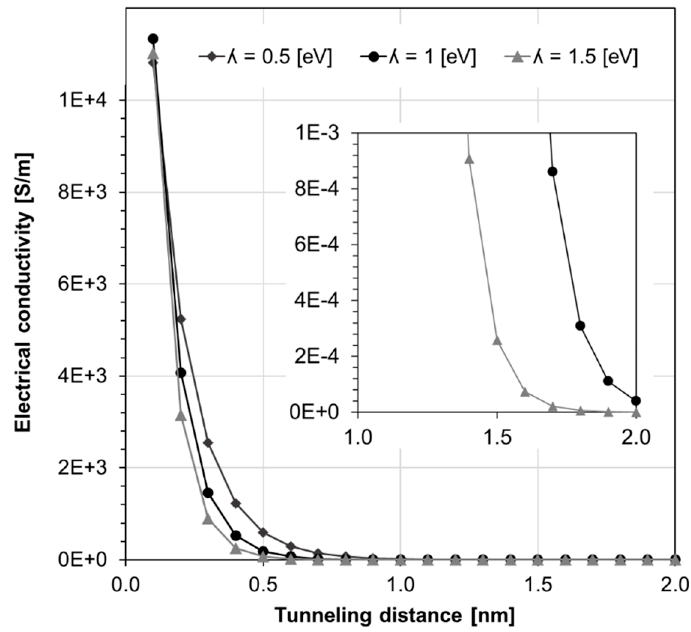
Figure 7. Electrical conductivity versus tunneling distance for different polymer barrier heights λ , based on Equation (7).